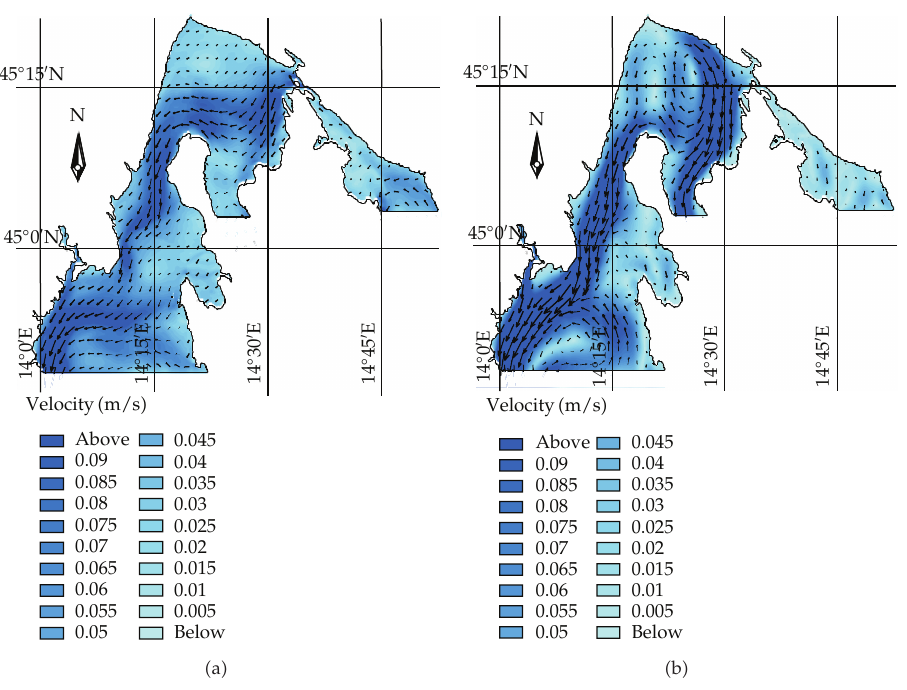
Figure 4: Modelled current fields in the surface layer (cid:4) 0–2m depth (cid:5) averaged over simulated winter (cid:4) 28/2/2008–9/3/2008 (cid:5) left and summer period (cid:4) 21/7/2008–31/7/2008 (cid:5) right.